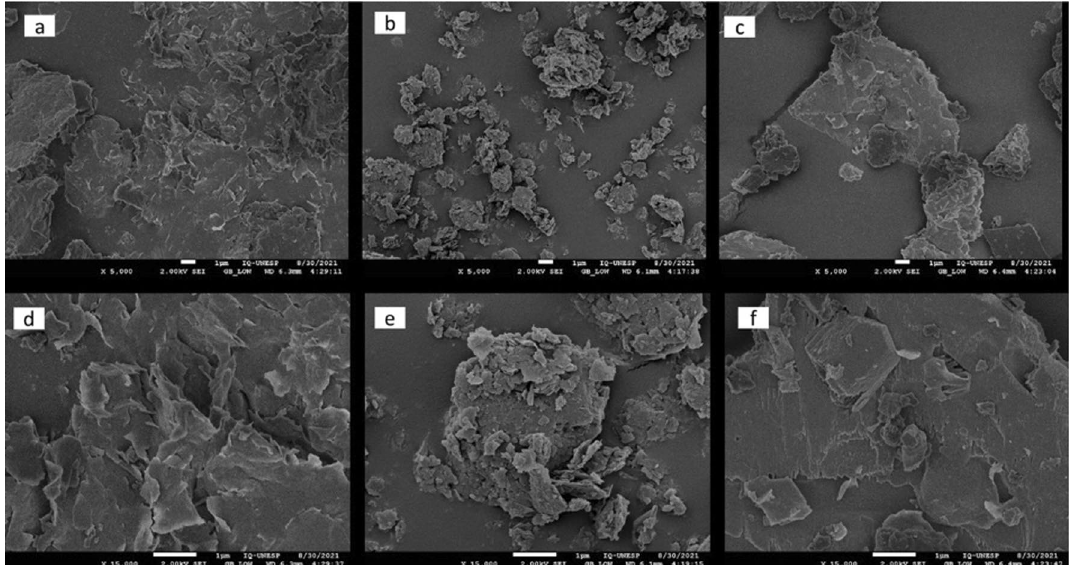
Figure 4. SEM images at 5000× magnification of ( a ) MMt nanoparticles, ( b ) graphene oxide ( c ) hybrid GO/ MMt and 15,000× magnification of ( d ) MMt nanoparticles, ( e ) graphene oxide, and ( f ) hybrid GO/MMt.